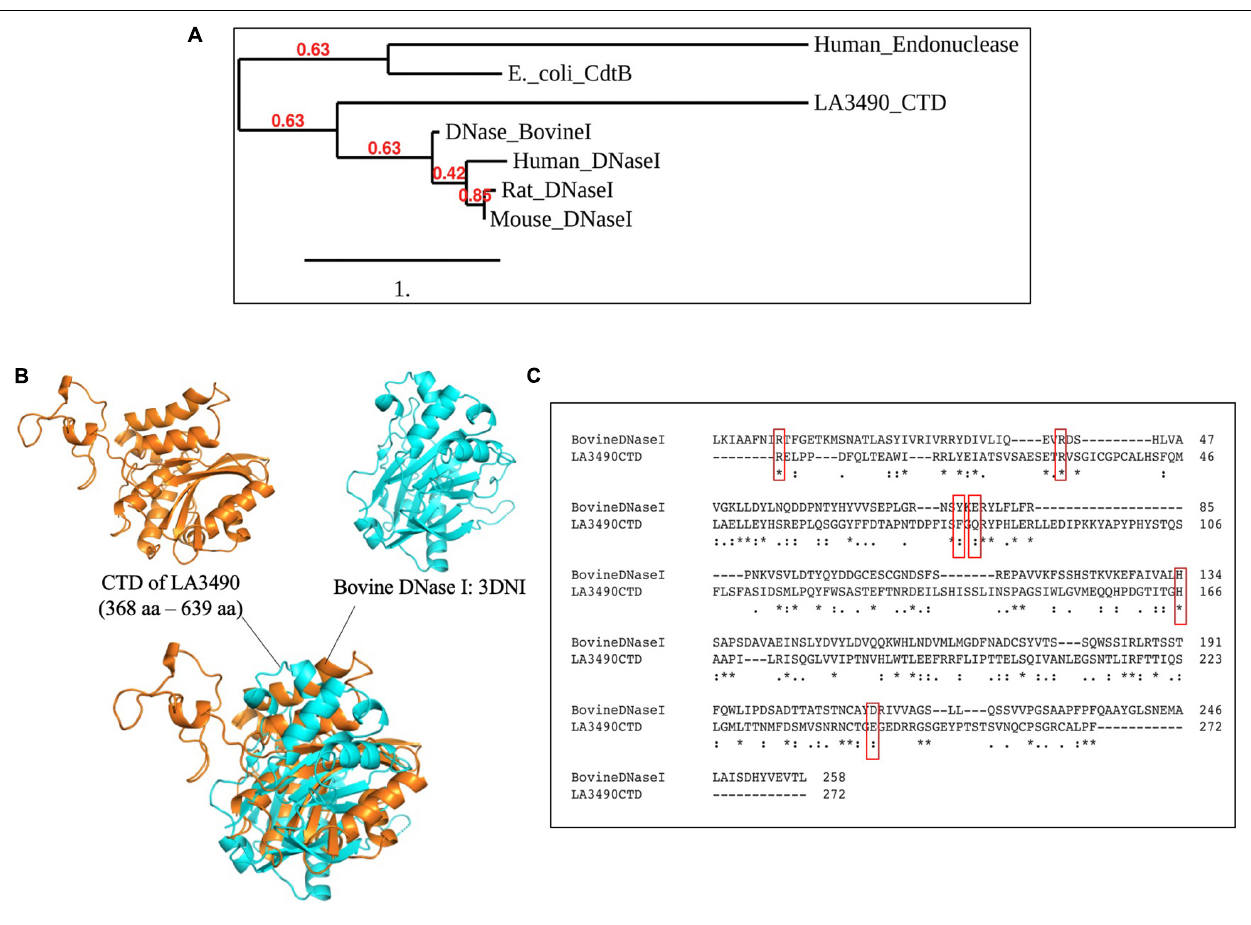
FIGURE 7 | CTD of LA3490 possess conserved active site residues identical to bovine DNase I. (A) Phylogenetic tree based on amino acid sequence alignment from CTD of LA3490, bovine DNaseI (uniport ID: P00639), mouse DNase1 (P49183), rat DNase1 P21704, human DNaseI (P24855), E. coli _CdtB (Q46669), and human endonuclease (P27695) was generated using https://www.phylogeny.fr. Scale bar, one substitution per amino acid site. Numerals indicate the statistical reliability of the branching order as determined by bootstrap analysis of 100 alternative trees. (B) Superimposition of CTD of LA3490 (368–639 aa) and bovine DNase (PDB: 3DNI) are predicted structural similarity in the active sites of bovine DNaseI with RMSD of 9.012 Å. (C) Clustal Omega-based multiple sequence alignment of CTD of LA3490 and bovine DNaseI (P00639) showing percentage identity of 20.18%. Red boxes represent the catalytic active sites in bovine DNaseI, which are highly conserved in CTD of LA3490. The ‘*’ indicates identical amino acids in the multiple sequence